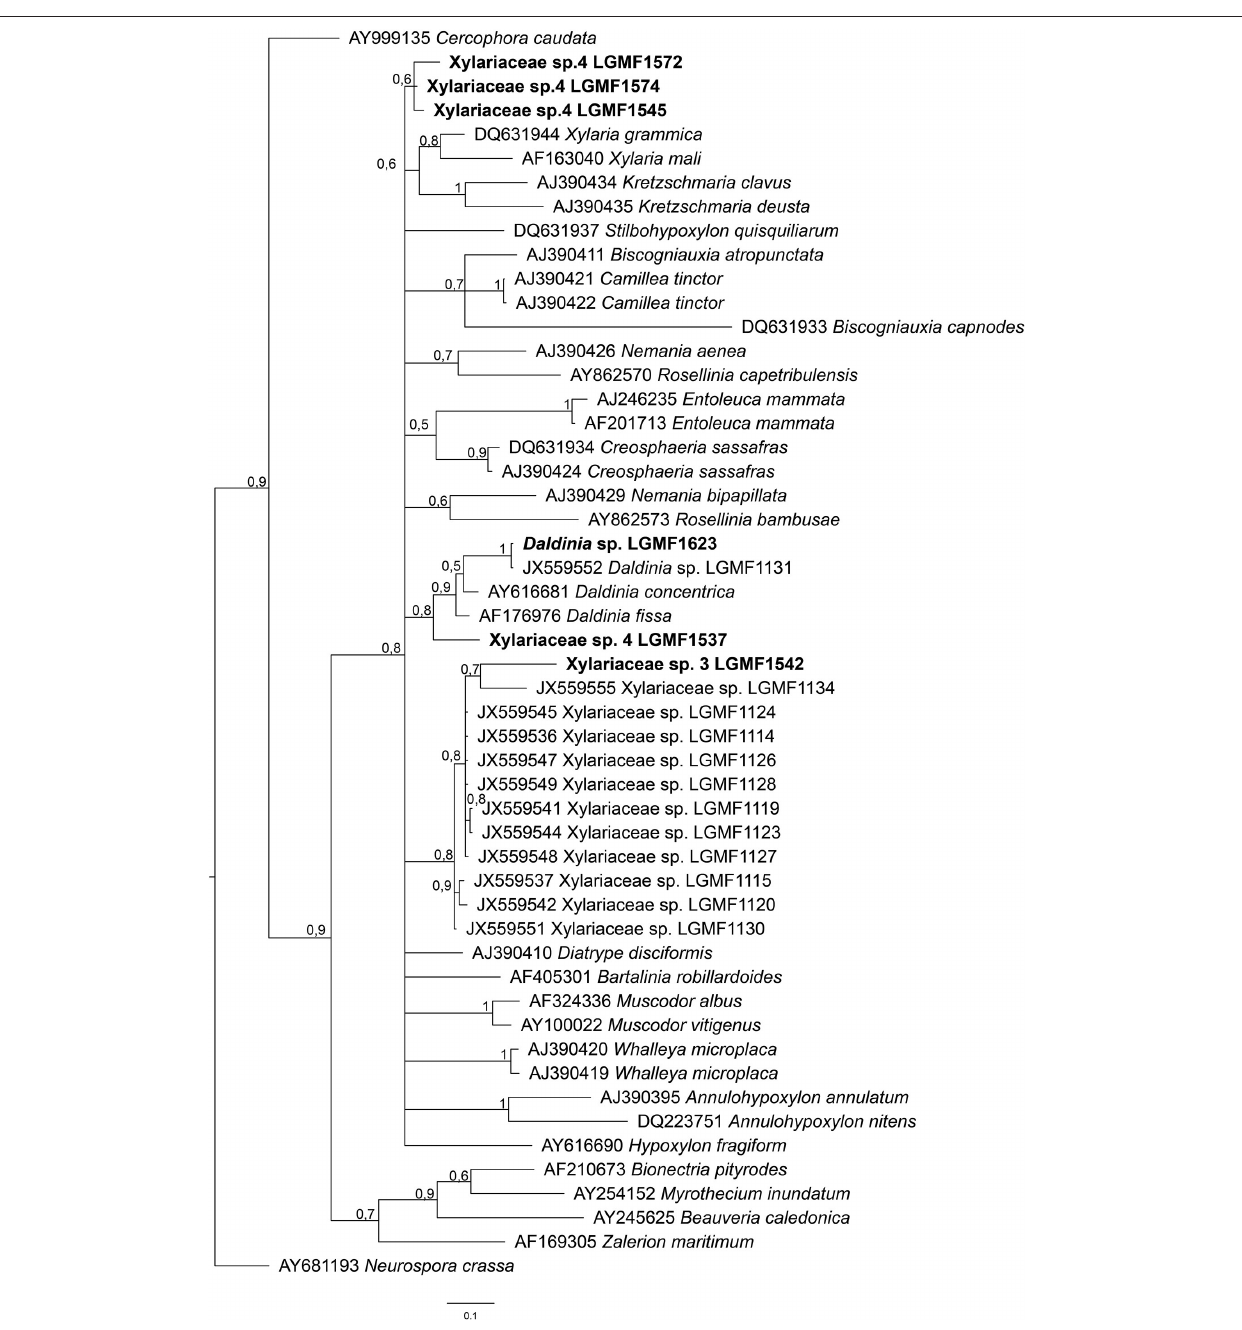
( Table 2 , Figure S28) as seen in PERMANOVA ( p >